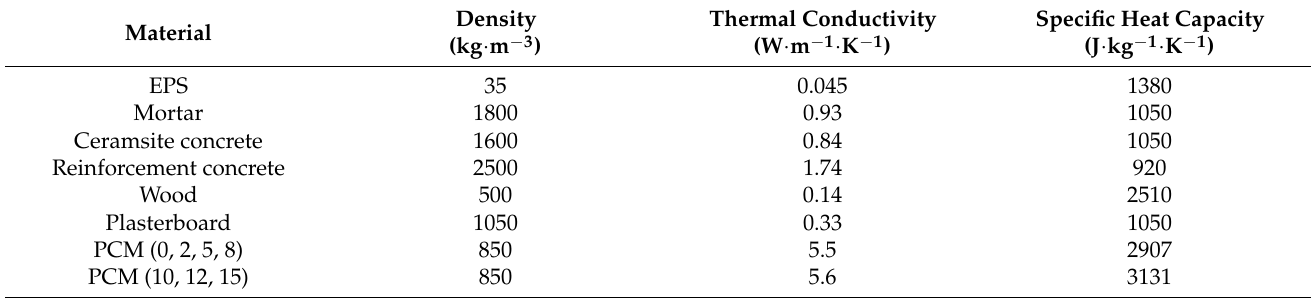
Table 2. Thermophysical properties of the building